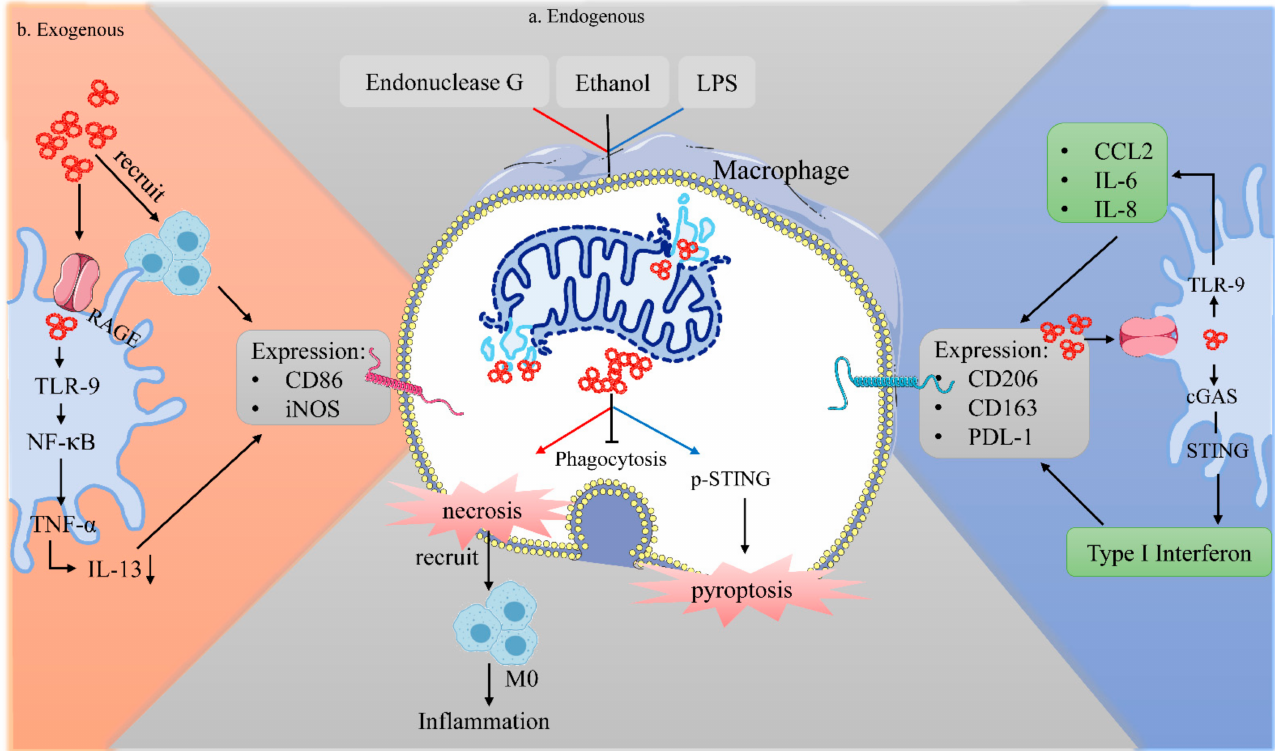
Figure 3. The biological effects of endogenous and exogenous mtDNA on macrophages.